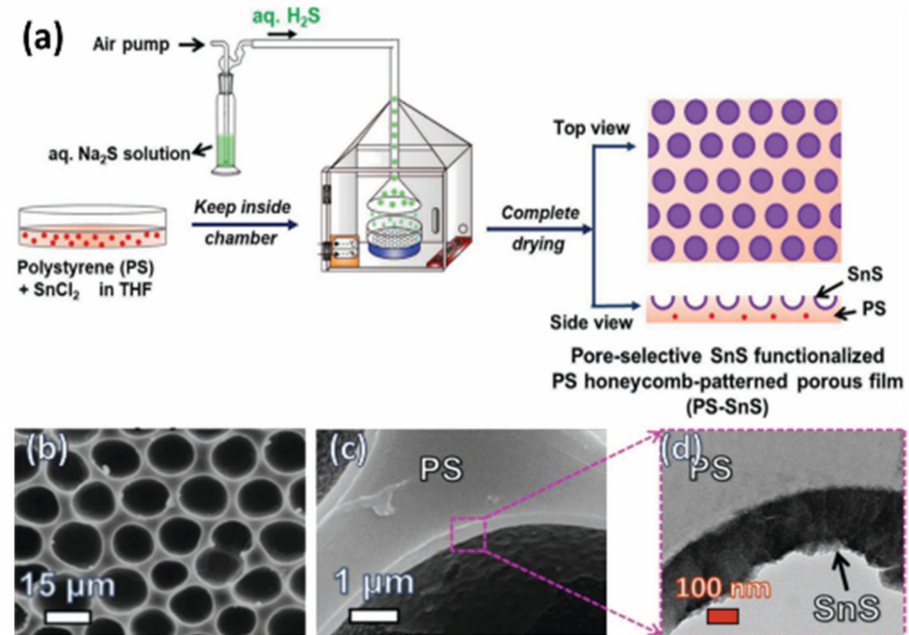
Figure 18. ( a ) Schematic representation showing the experimental process for the pore-selective SnS-functionalized PS HCP film using a modified BF method. SEM images of PS HCP films fabricated by casting PS solution containing SnCl 2 under ( b , c ) aq. H 2 S humidity, and ( d ) magnified TEM image showing a thin layer of SnS. Reprinted with permission from ref. [109]. Copyright 2018 Advanced Materials